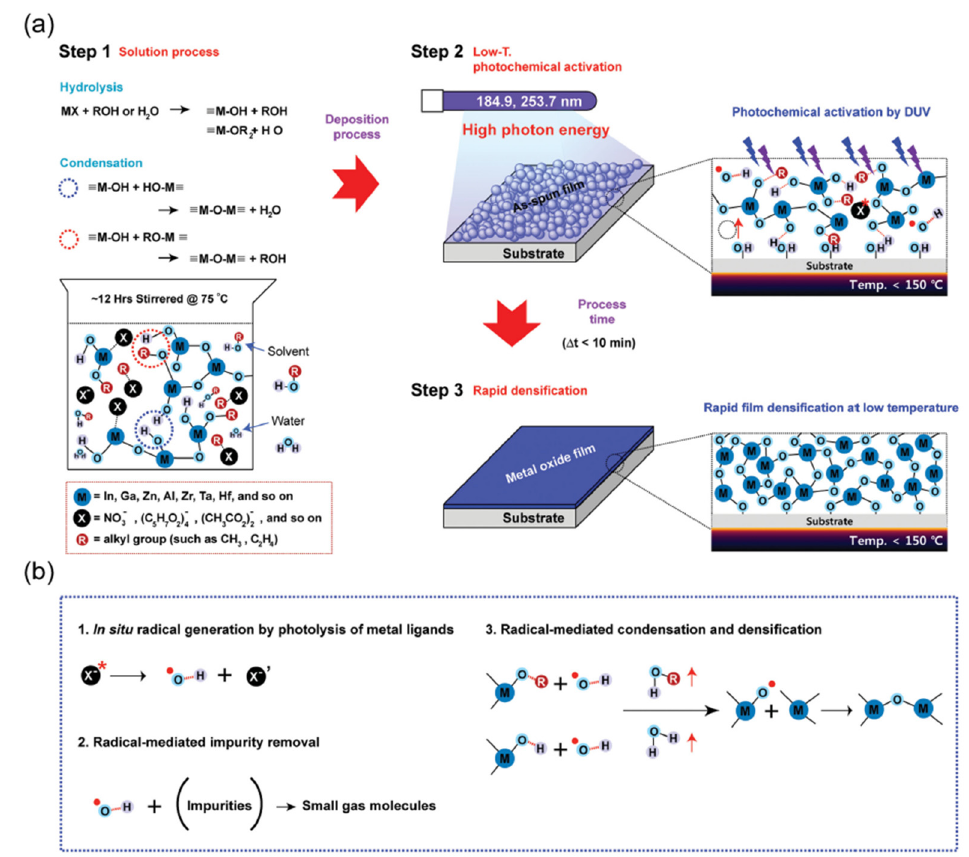
Figure 5. Photoactivation of sol–gel metal oxide materials and the proposed mechanism: ( a ) overall schematic illustration of the rapid low-temperature photoactivation of various sol–gel metal oxide films; ( b ) proposed physicochemical mechanism of the rapid low-temperature photoactivation pro- cess via photochemical activation (direct photodecomposition of impurities, in situ radical formation, enhancement of rapid condensation and densification) [29].